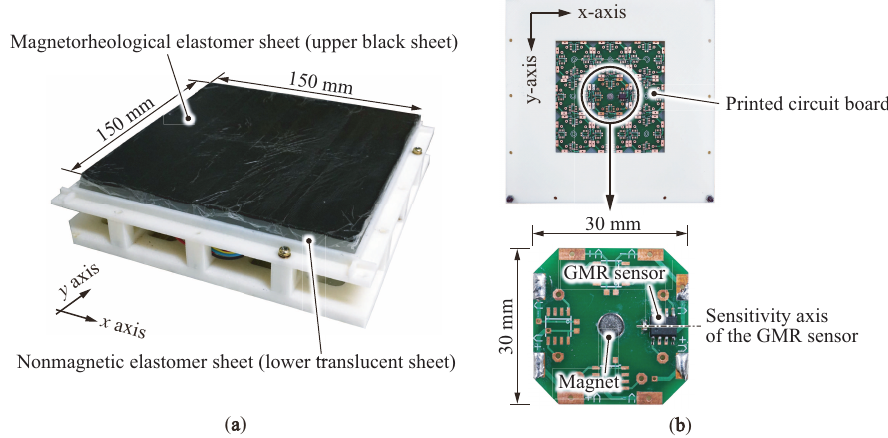
Figure 4. Overview of the fabricated tactile sensor used in this study: ( a ) Appearance of the sensor; ( b ) Bottom view.